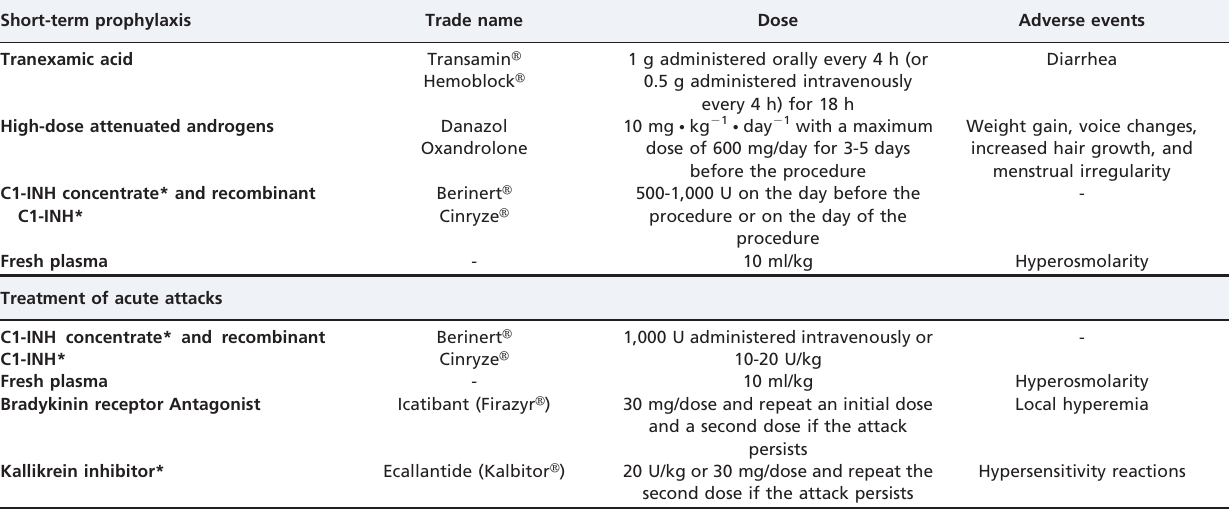
Table 6 - Drugs used for the short-term prophylaxis and treatment of acute attacks of hereditary angioedema. Short-term prophylaxis